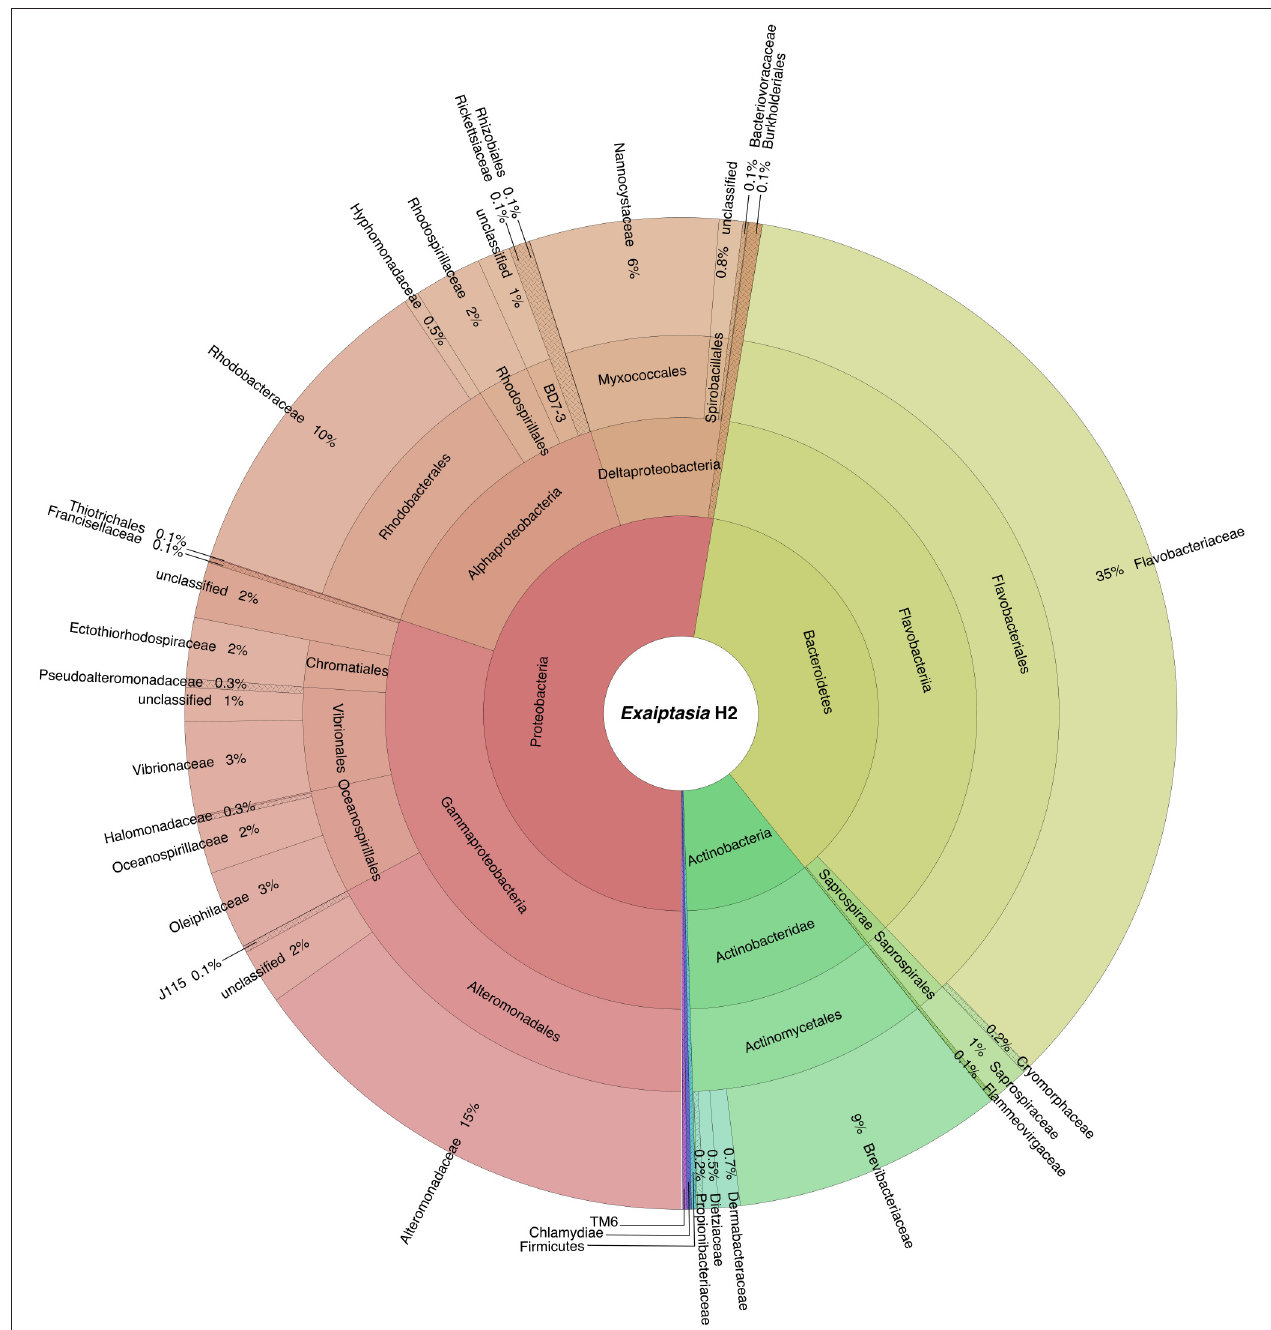
FIGURE 1 | Taxonomic community composition of bacteria associated with Exaiptasia H2. The inner ring represents different phyla, and as the plot progresses outwards, there is an increasing taxonomic resolution for each ring (i.e., class, order, family, respectively). Only OTUs with relative abundance > 0.1% are